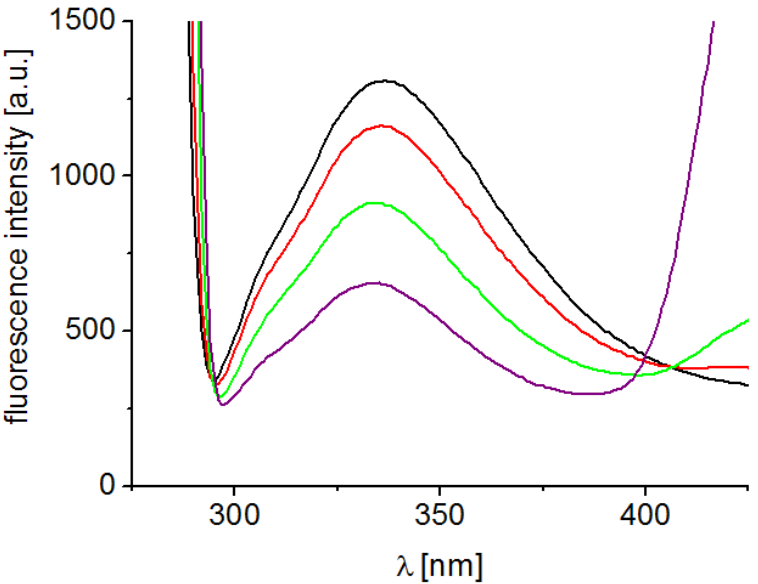
Figure 3. Fluorescence emission spectra of aromatic amino acids in suspension of spinach chloroplasts without and with compound 7 (c = 0, 6, 24 and 48 μ mol/L; the curves